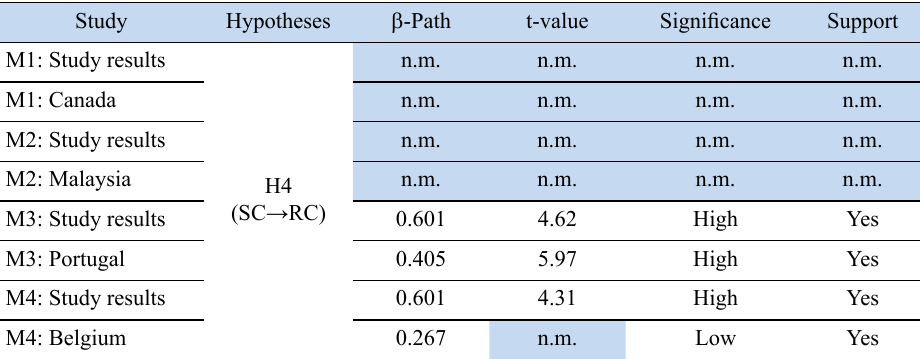
Table 6. Comparative summary results for Hypothesis